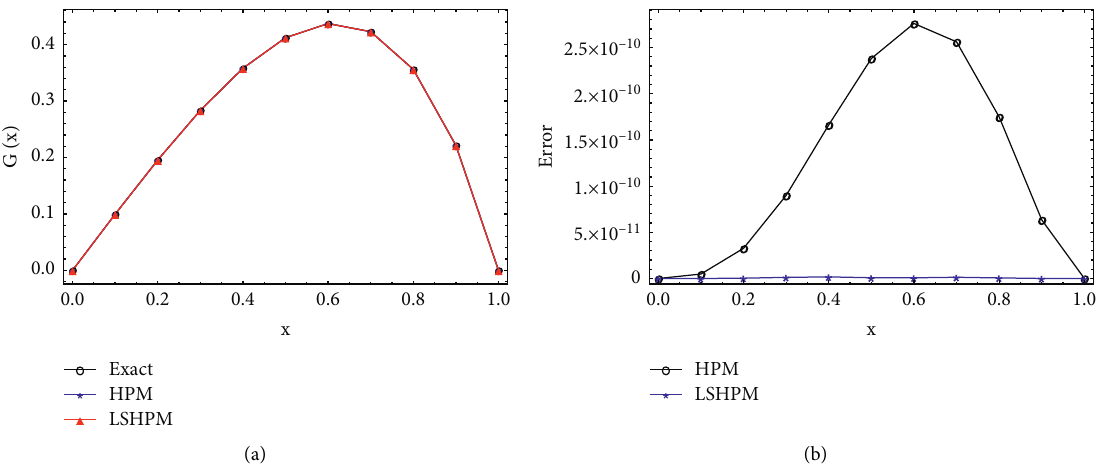
Figure 7: Graphical representation of solutions and errors in Problem 7. (a) Comparison of Exact, HPM, and LSHPM solutions. (b) Comparison of absolute errors of HPM and LSHPM.